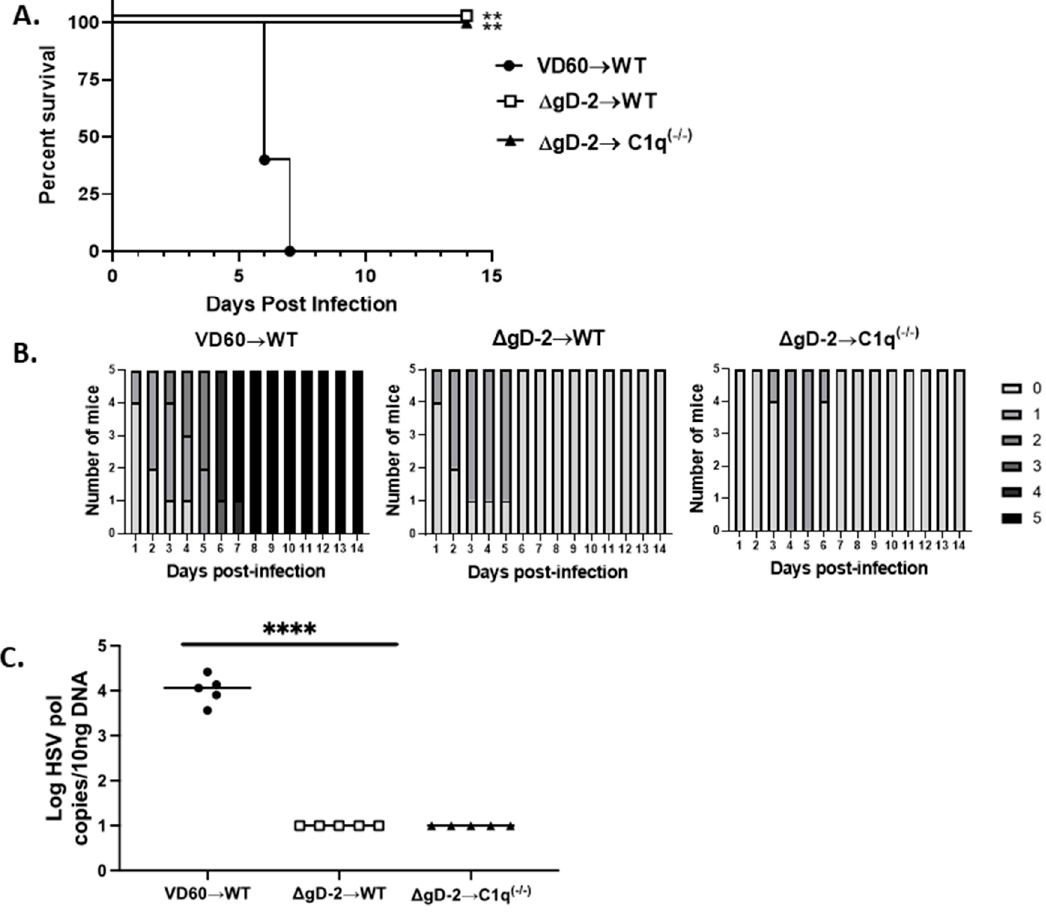
Figure 5. Passive transfer of immune serum from wild-type mice vaccinated with ∆ gD-2 protects wild-type and C1q-/- mice. Pooled immune serum obtained from 5 ∆ gD-2 vaccinated mice were assayed for IgG content and then administered intraperitoneally (750 µ g total IgG/mouse) to wild-type or C1q-/- mice 1 day prior to challenging the mice by skin scarification with 5 × 10 4 PFU/mice of HSV-2 (4674). Survival curves ( A ) and disease scores ( B ) are shown, and the survival was compared using the Gehan-Breslow-Wilcoxon test ( n = 5 mice per group ** p < 0.01). ( C ) Viral spread to sacral ganglia was determined using a quantitative PCR at time of euthanasia, **** p < 0.0001,